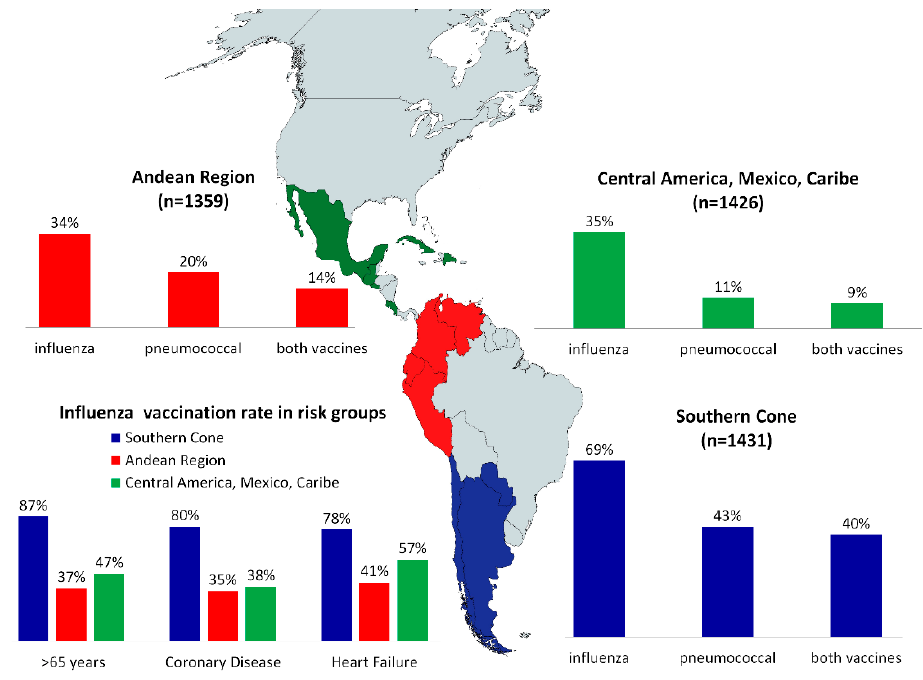
Figure 1. Immunization rate by geographic zone.